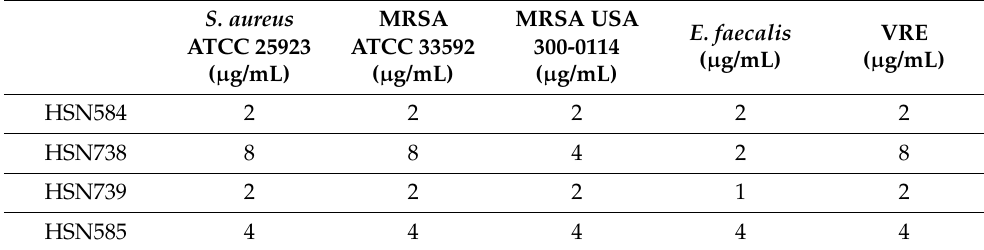
Figure 4. HSN490 analogs used for the structure activity relationship study. Table 1. HSN490 analogs’ minimal growth inhibition concentrations (MICs) against S. aureus , MRSA, vancomycin-sensitive E. faecalis and VRE faecalis.